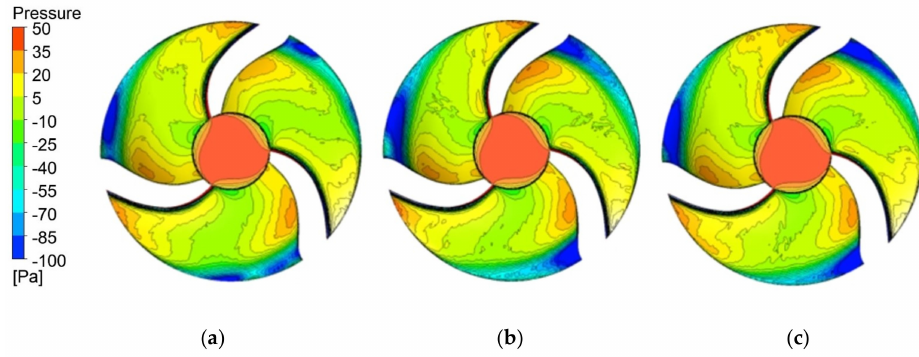
Figure 10. Pressure distribution on the suction surface: ( a ) Case-Basic, ( b ) Case-10, and ( c ) Case-12.